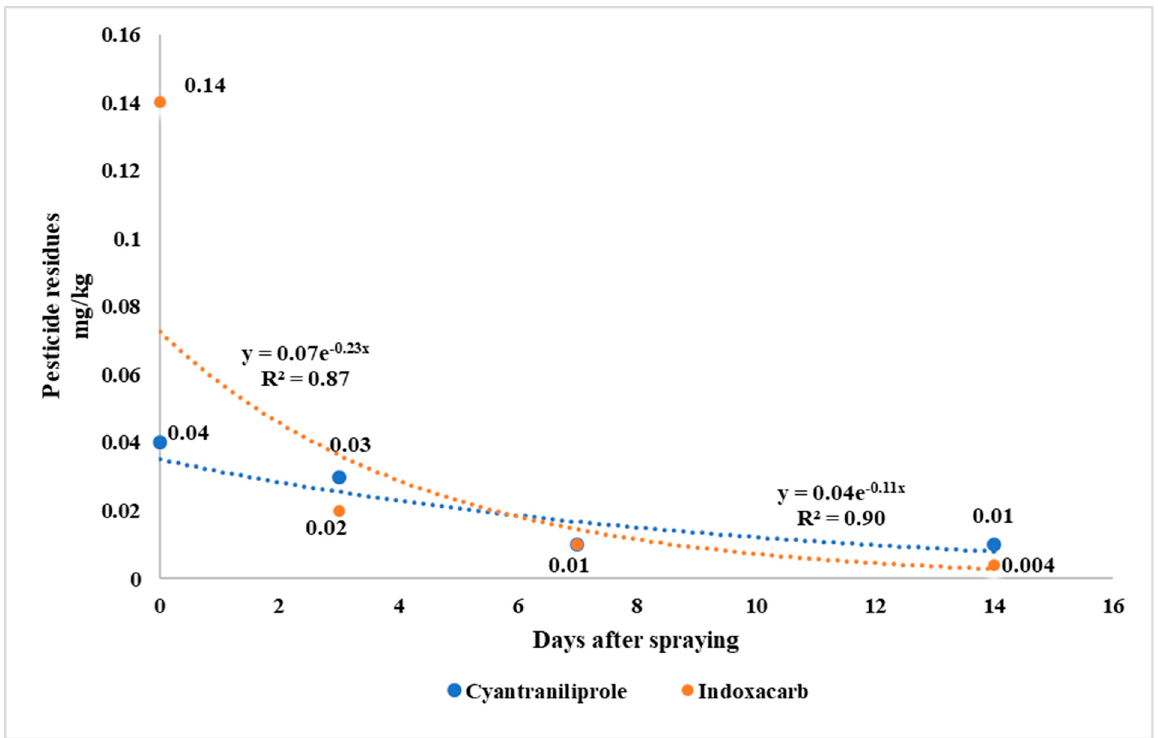
Figure 1. The cyantraniliprole and indoxacarb insecticide dissipation patterns (%) in wild